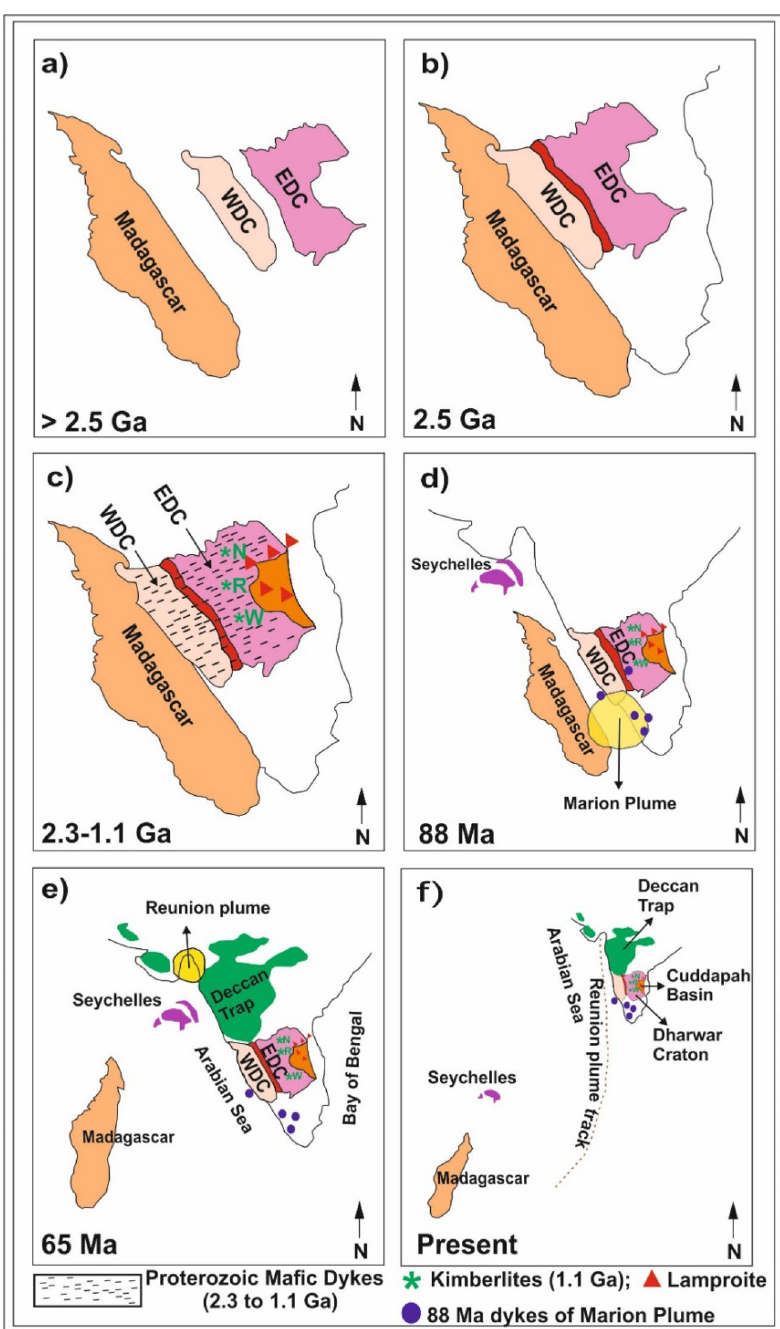
Figure 9. A cartoon illustrating the major tectonic activities on the west coast of the Indian shield. ( a ) Locations of Madagascar, western and eastern Dharwar cratons (WDC and EDC) earlier to 2.5 Ga, ( b ) Accretion of WDC and EDC during 2.5 Ga, ( c ) Mafic dyke swarms during the post-collisional period (2.3– 1.1 Ga) and large-scale kimberlite-lamproite magmatic event at ca.1.2–1.1 Ga ( d ) Separation of Madagascar from the west coast of India due to the Marion plume activity at 88 Ma and opening of the ocean in the western part of Dharwar craton, ( e ) Separation of Seychelles from the west coast due to Reunion mantle plume activity at 65 Ma and emplacement of Deccan basalts, ( f ) Present-day locations of various units in south India, including the Dharwar craton. N-Narayanpet, R-Raichur, W-Wajrakarur are 1.1 Ga kimberlite